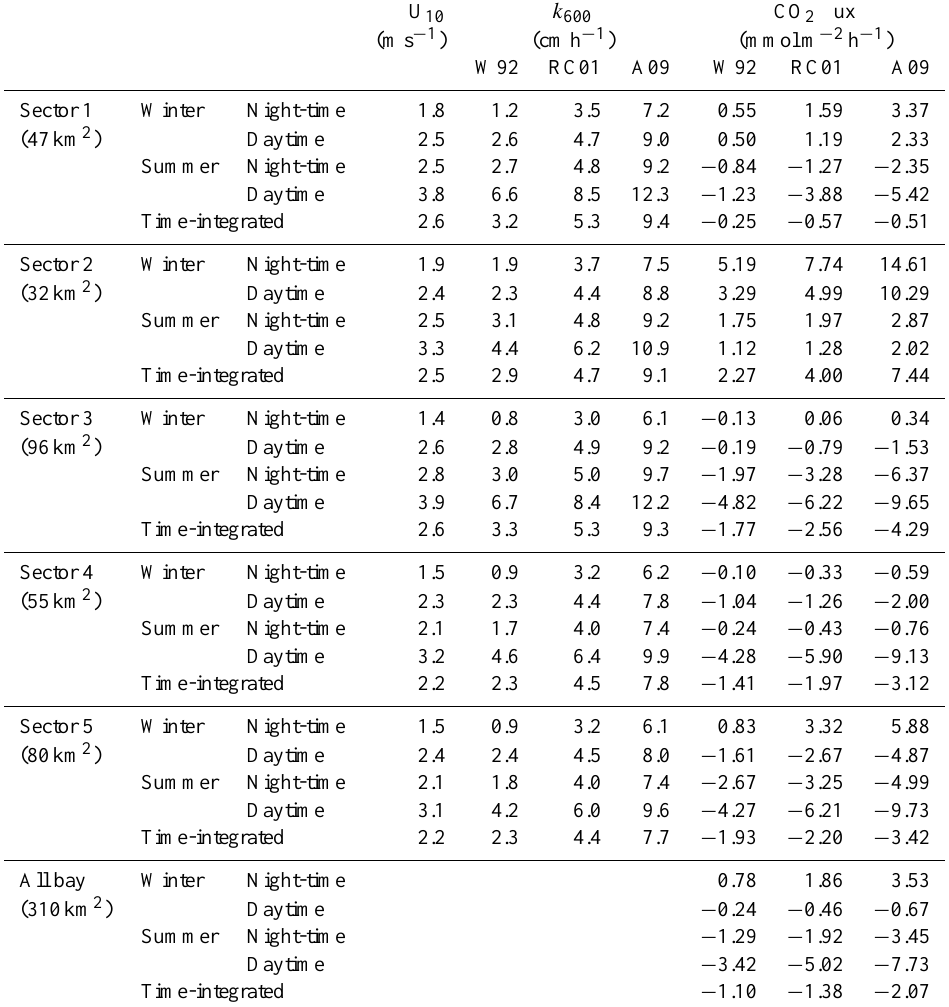
Table 2. Summary of calculated mean values for wind speed ( U 10 ), gas exchange coefficient ( k 600 ) and CO 2 fluxes at the air–sea interface in each sector and the whole of Guanabara Bay. Diurnal variations (night-time < 09:30; daytime > 09:30), seasonal means (winter and summer) and time-integrated values are reported. W92 is the data calculated according to k 600 of Wanninkhof (1992), RC01 is the data calculated according to k 600 of Raymond and Cole (2001), and A09 is data calculated according to k 600 of Abril et al. (2009). U